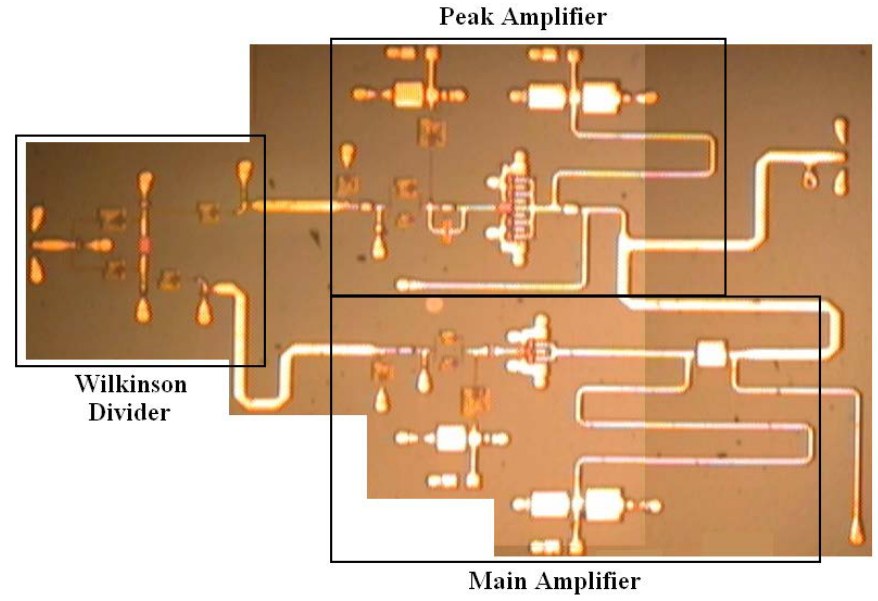
Figure 2. Microscope picture of the Doherty PA MMIC (microwave monolithic integrated circuits) fabricated with the GigaHertz Centre foundry process. The building blocks are